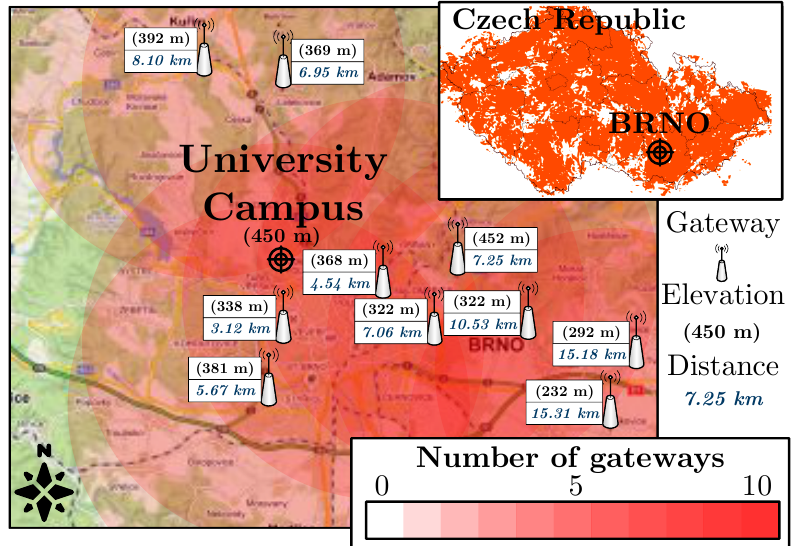
Figure 6. Coverage map of the public LoRaWAN network in the Czech Republic (upper-right corner) and coverage estimation of the nearest public network gateways in the selected